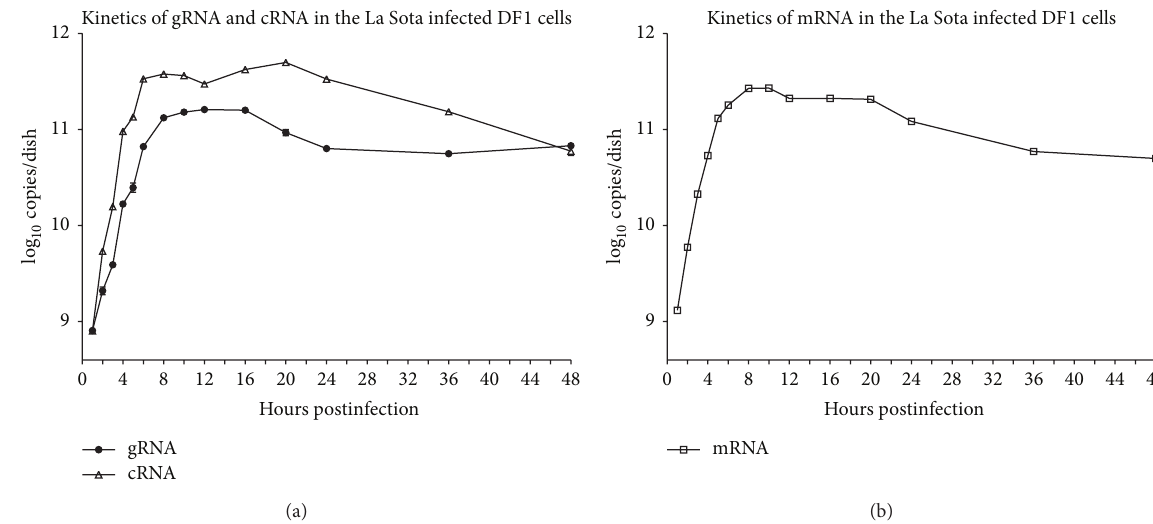
Figure 4: Kinetics of gRNA, cRNA, and mRNA in La Sota infected DF-1 cells. DF1 cells were incubated with NDV La Sota at an MOI of 1 for 20 min. The gRNA, cRNA, and mRNA were quantitatively analyzed at 1, 2, 3, 4, 5, 6, 8, 10, 12, 16, 20, 24, 36, and 48 hpi. (a) Kinetics of gRNA and cRNA. (b) Kinetics of NP gene